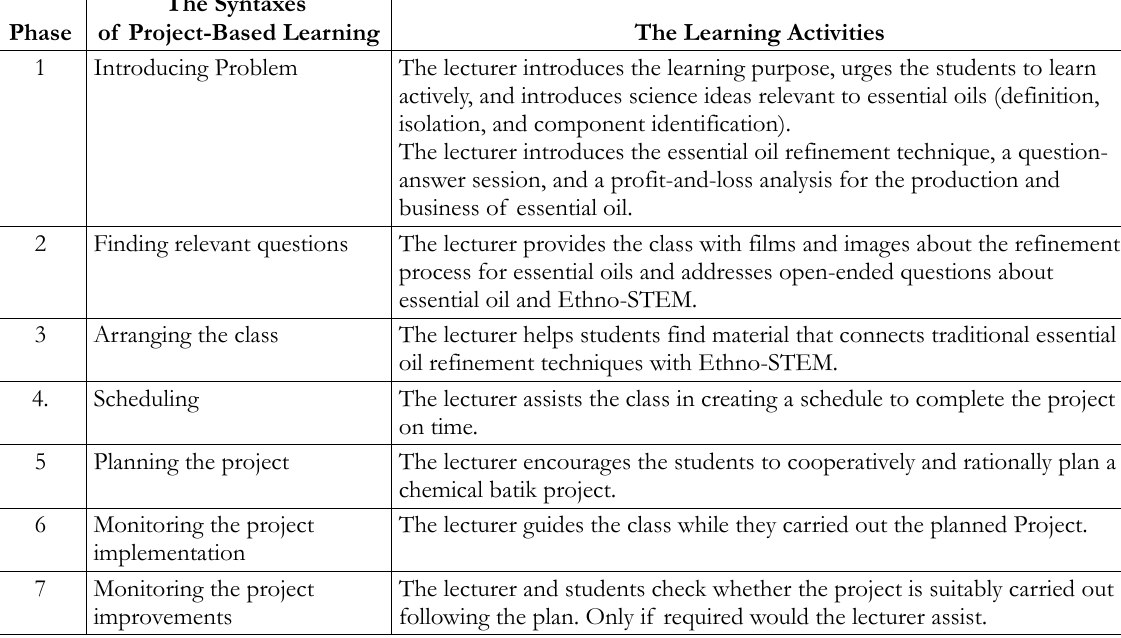
Table 2. Syntax of secondary metabolite learning model with Ethno-STEM approach on the topic of essential oils